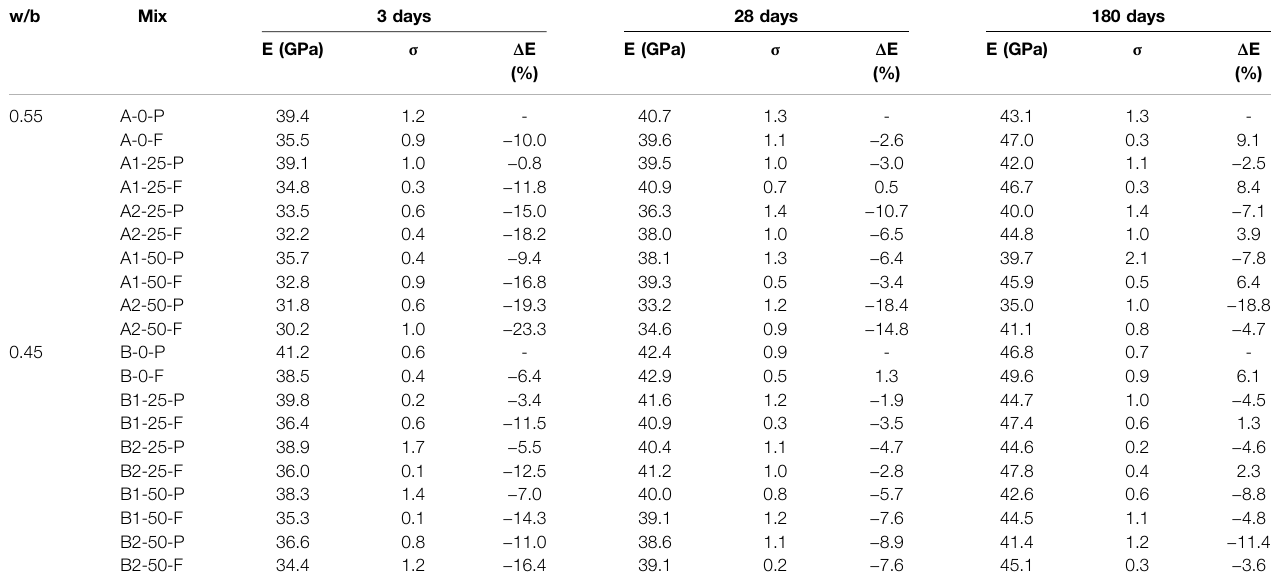
TABLE 7 | Elastic modulus